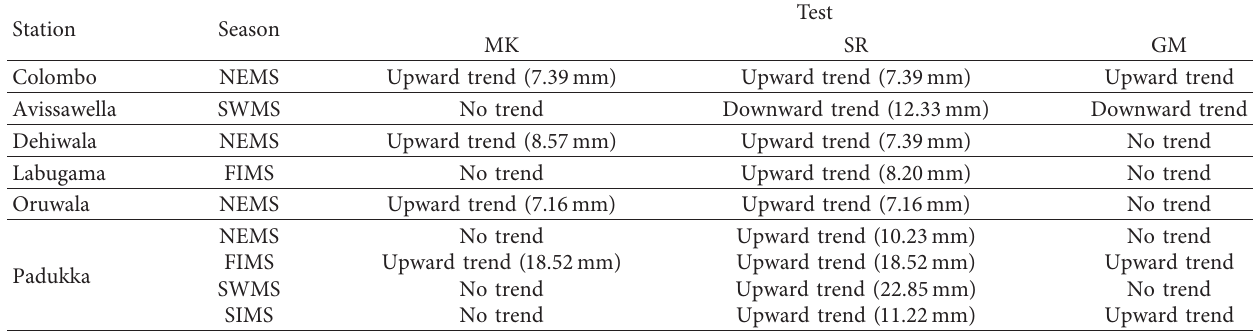
Table 3: Trend analysis results for seasonal rainfall variation at 5% significance level.